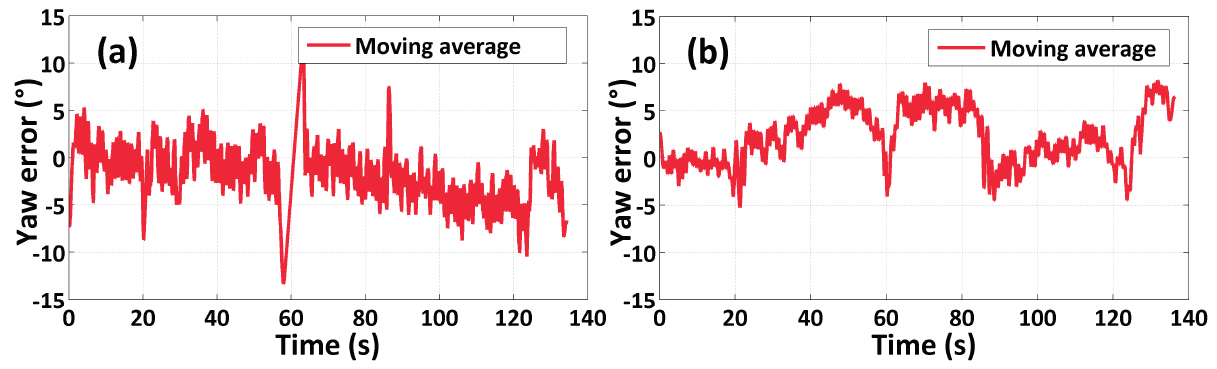
Figure 10. Moving average of yaw error: ( a ) multi-sensor system on the pedestrian test; ( b ) multi-sensor system on the quadrotor